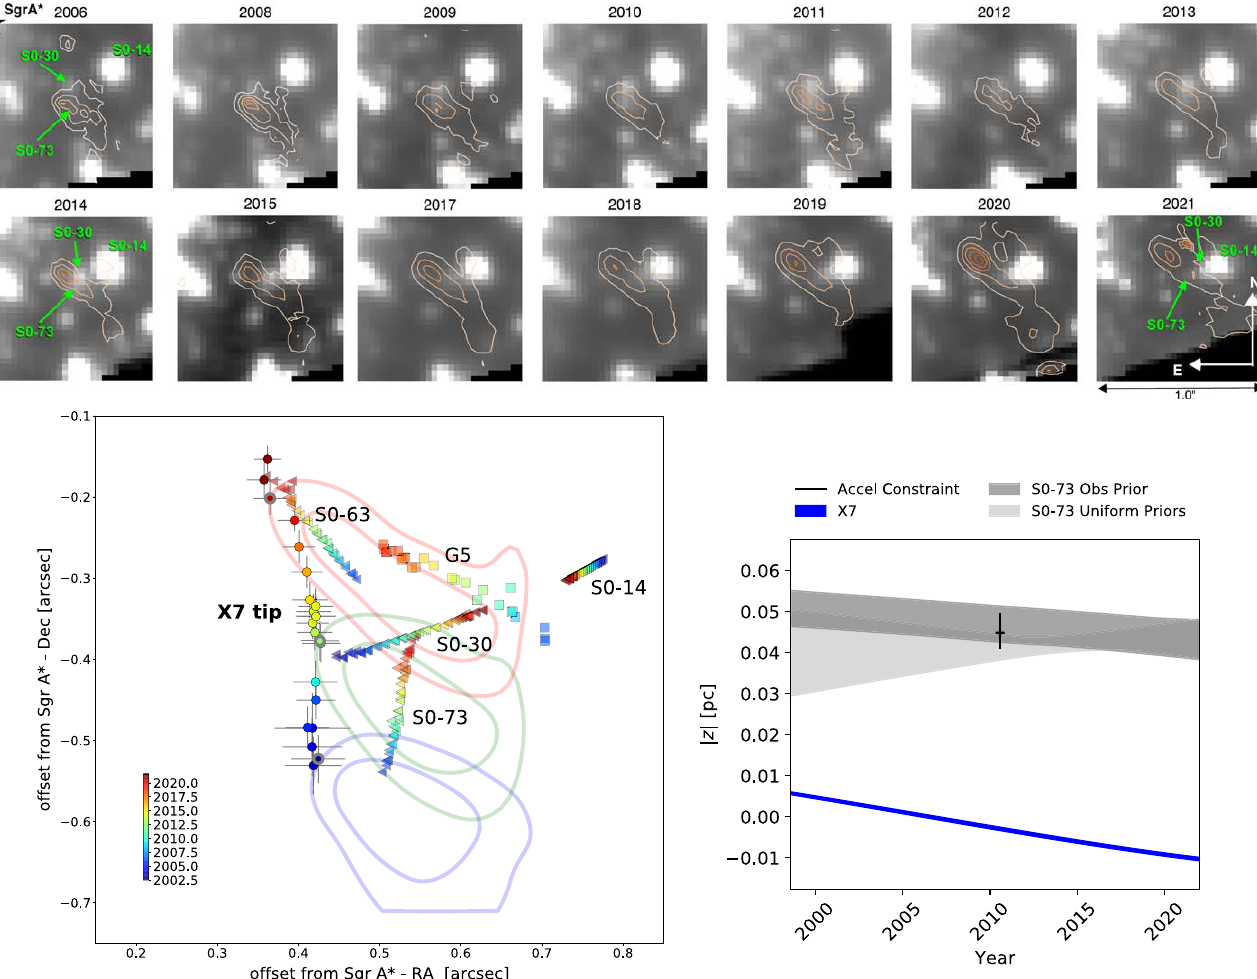
Figure 8. X7 is not associated with any of the nearby, detectable stellar sources that have crossed its path. The top panel shows contours of Br- γ emission overplotted onto maps of stellar continuum emission for all epochs. In this view, S0-73 and S0-30 show line-of-sight crossings with X7. However, the proper motions of both of these stars have directions different from that of X7, making them unlikely sources of the X7 gas fi lament. The bottom left panel shows the proper motion measurements of the tip of X7, contours of the whole feature ( obtained from NIRC2- Lp for 2003, 2012 and 2020 ) , and the proper motions of nearby stellar objects ( stars are shown as triangles and the G object G5 as squares ( Do et al. 2019; Ciurlo et al. 2020 )) . The proper motion measurements of the tip have much larger uncertainties than those of the stars, because of the extended nature of X7. The bottom right panel shows the modulo of the z position of X7 and S0-73, according to their orbital models ( one sigma uncertainties are shown ) together with S0-73 z position inferred from our acceleration measurement. It is evident from the 3D orbits that S0-73 is not coincident with